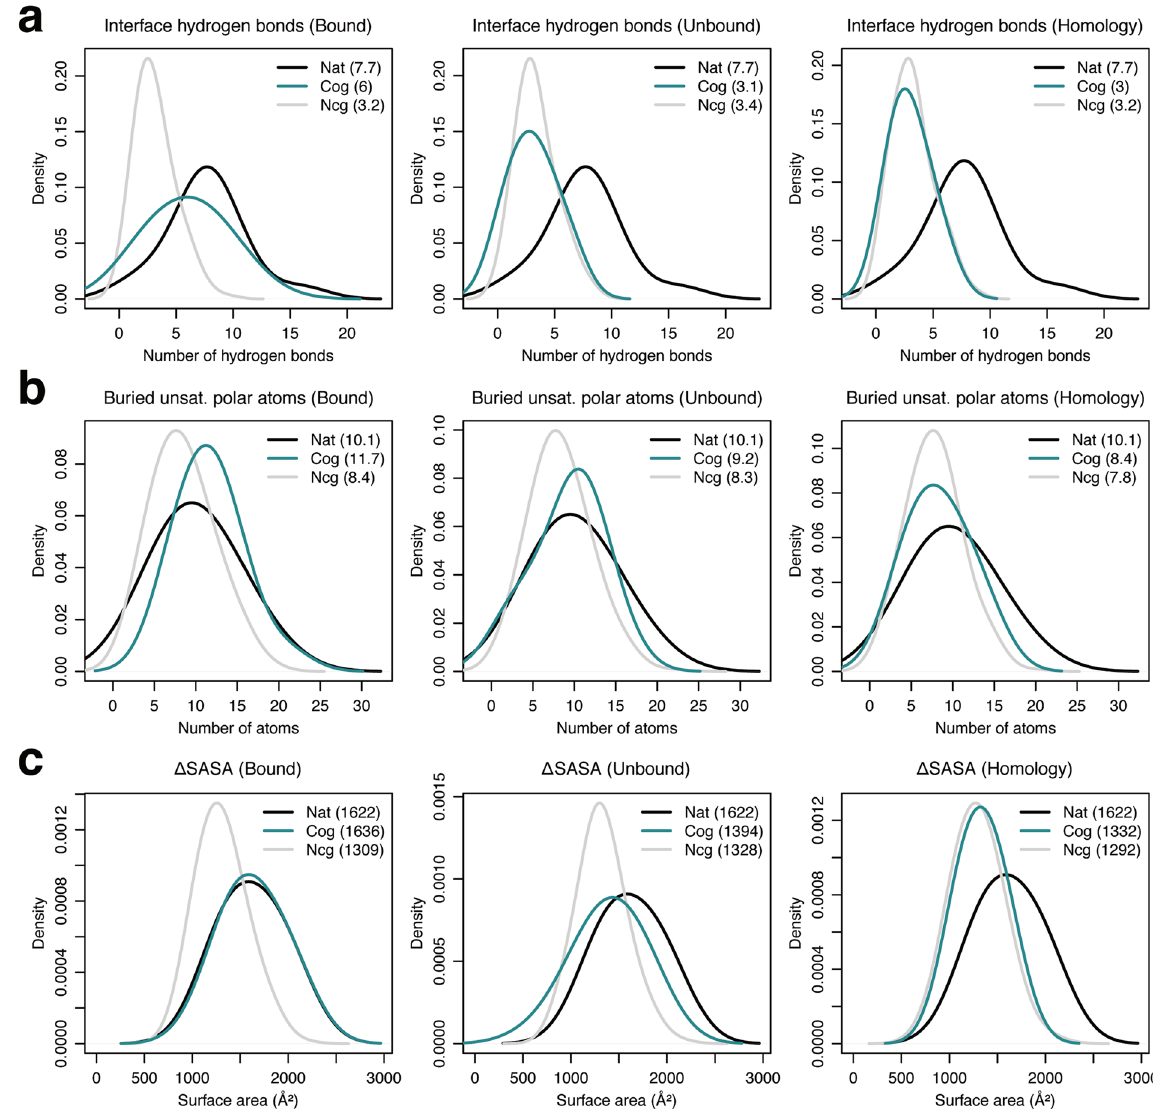
Figure 6. Interface metric distributions for local dock models. Kernel density estimate curves for the number of ( a ) interface hydrogen bonds, ( b ) buried unsatisfied interface polar atoms, and ( c ) surface area change upon binding ( Δ SASA) for the native crystal complexes (black), and the top-scoring cognate (turquoise) and non-cognate (grey) models generated using local dock for bound, unbound, and homology antibody–antigen